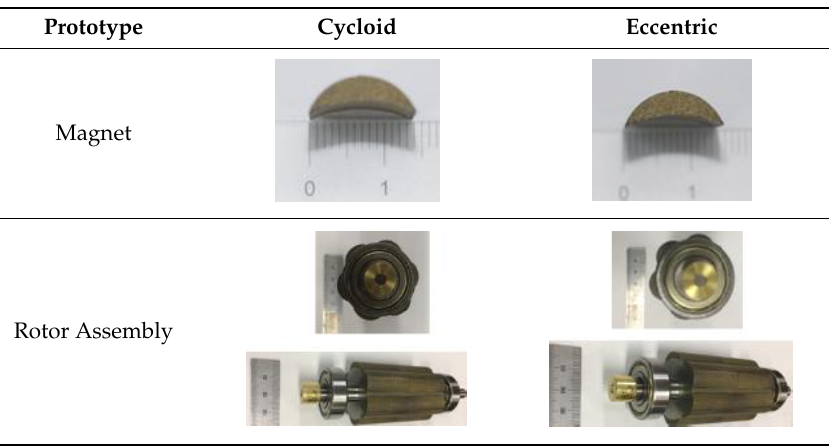
Table 4. Prototype: magnet and rotor assembly.